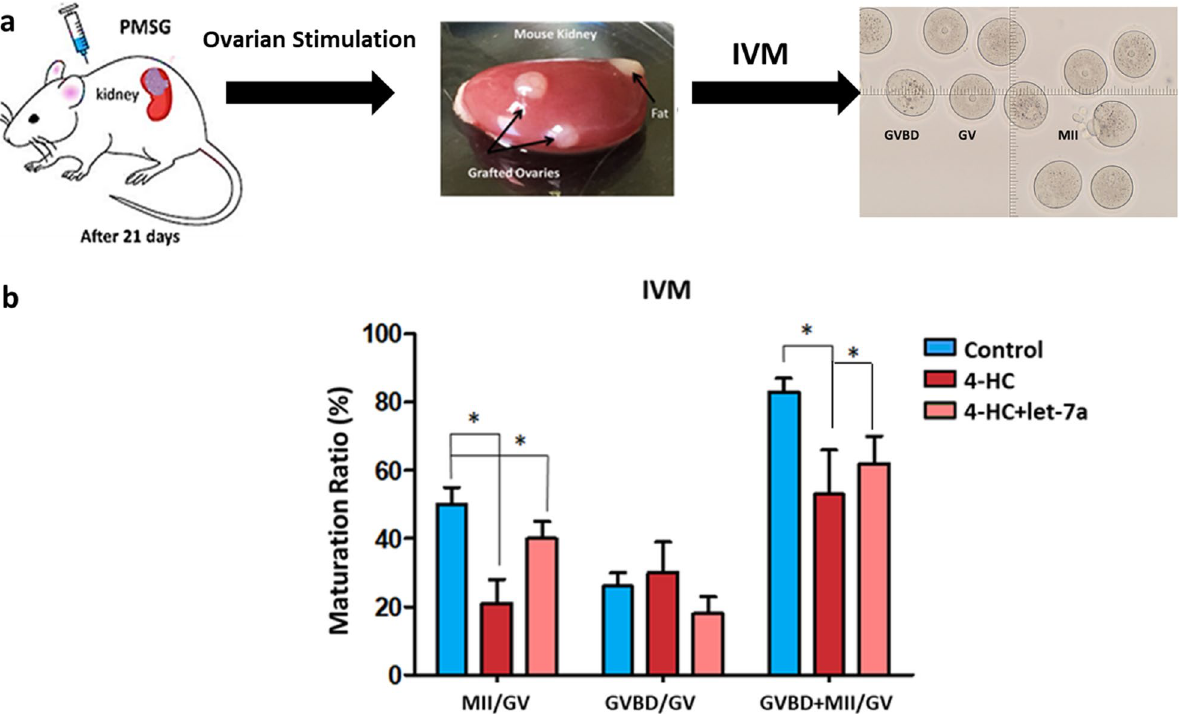
Figure 5. Oocyte maturation after three different types of treatment: control, 4-HC, and 4-HC + let-7a. ( a ) At day 21 post-transplantation, mice were injected with PMSG and grafted ovaries were collected to mechanically isolate OCC. The germinal vesicle (GV) oocytes were matured for 24 h before evaluation of the maturation rate ( b ) The number of GV oocytes that underwent maturation to germinal vesicle break down (GVBD) and metaphase II (MII) stage after 24 h in maturation medium were calculated and the maturation ratio was expressed as a percentage. The results are presented as the mean of at least 7 different experimental samples for each group (N ≥ 7). The error bars represent the standard error, * p <